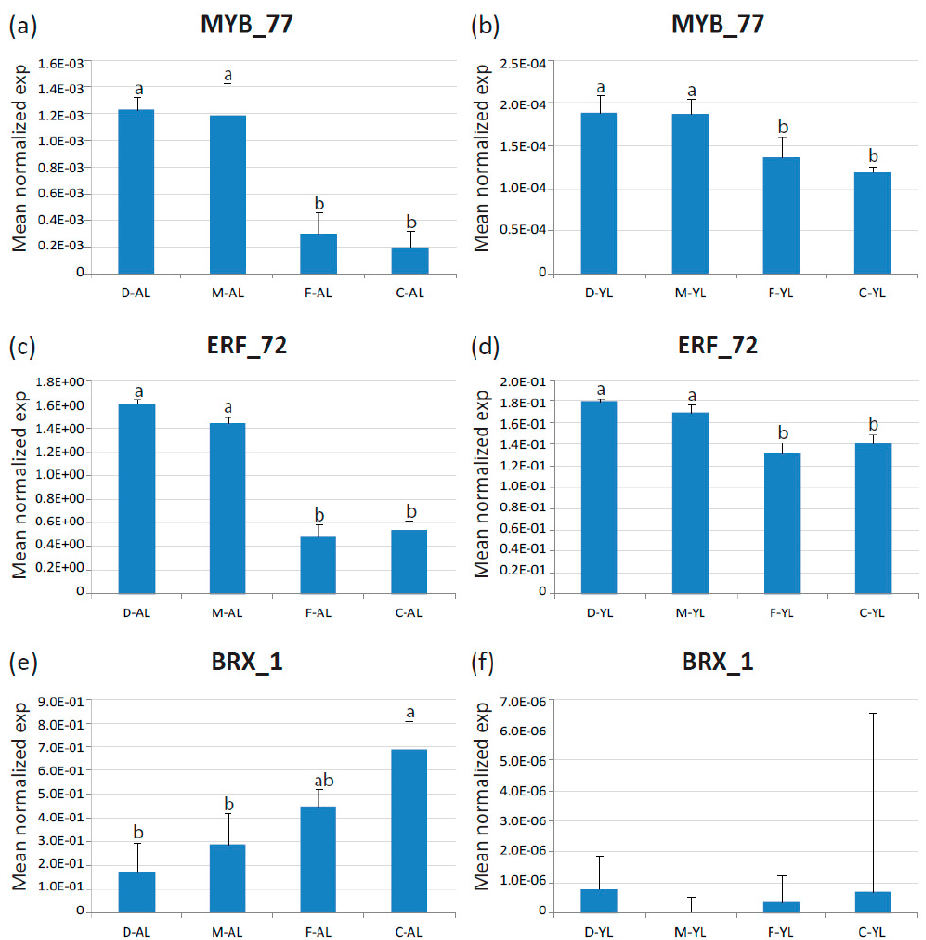
Figure 8. Expression of the three identified TF DEGs in adult (AL) and young (30-day-old, YL) leaves of endives (‘Domari’, D and ‘Myrna’, M) and escaroles (‘Flester’, F and ‘Confiance’, C) analyzed by quantitative real-time PCR. ( a – b ) Expression of CeMYB_77 in adult and young leaves, respectively; ( c – d ) expression of CeERF_72 in adult and young leaves, respectively; and ( e – f ) expression of CeBRX_1 in adult and young leaves, respectively. Data represent the average of two biological replicates with three technical replicates each. Error bars represent SD. Letters indicate significant differences.